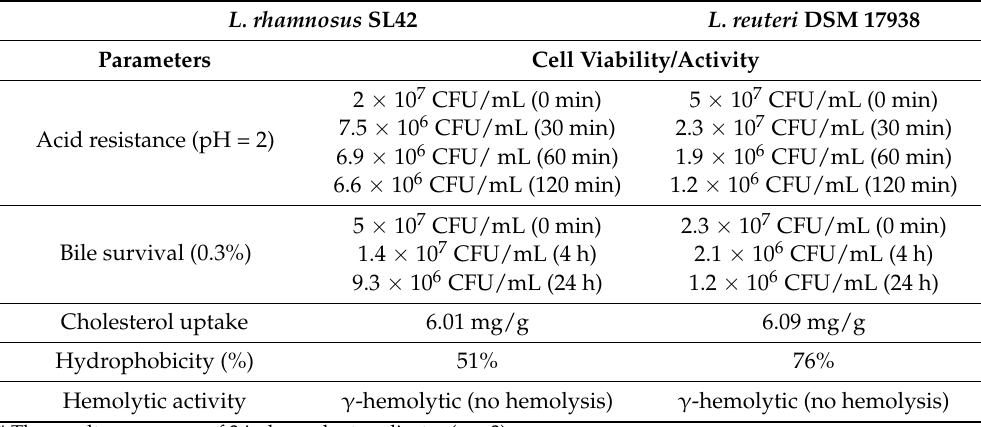
Table 1. Probiotic characteristics * of SL42 strain reported in this